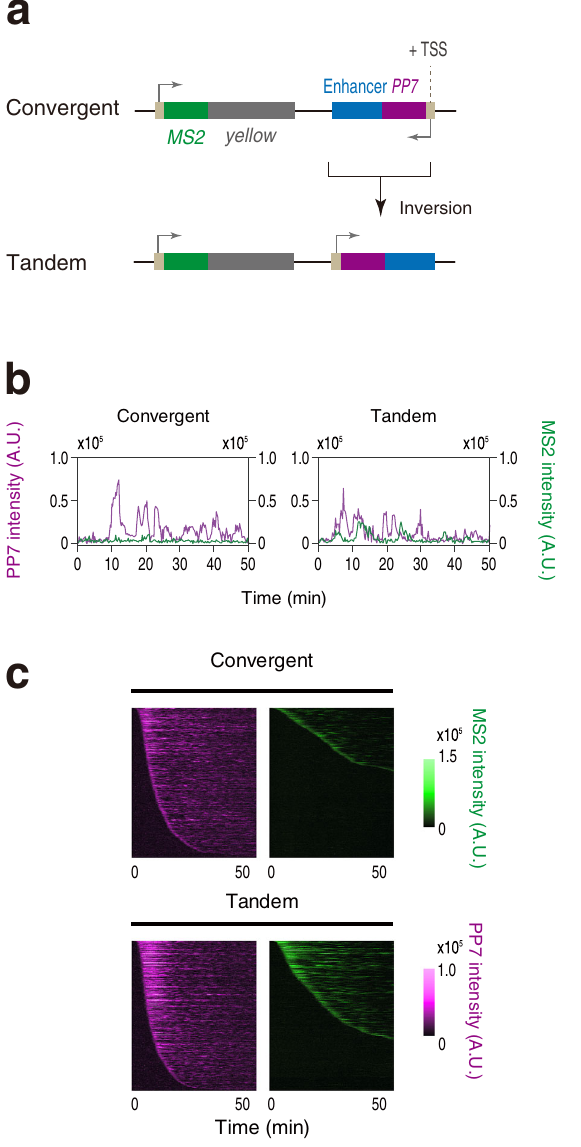
MS2burstfrequency.TheplotofConvergentisthesameastheplotof+TSSshown inFig.1f. f BoxplotshowingthedistributionofMS2burstsize.Theboxindicatesthe lower (25%) and upper (75%) quantile and the white line indicates the median. Whiskers extend to the most extreme, non-outlier data points. A total of 536 and 1055 MS2 bursts, respectively, were analyzed for the reporter locus driving non- coding enhancer transcription in a convergent or tandem orientation. The double hash mark on the y-axis indicates that >99% of the data points are presented. The plot of Convergent is the same as the plot of +TSS shown in Fig. 1g. g Boxplot showingthedistributionofthetotaloutputofMS2transcription.Theboxindicates the lower (25%) and upper (75%) quantile and the white line indicates the median. Whiskers extend to the most extreme, non-outlier data points. The plot of Con- vergent is the same as the plot of +TSS shown in Fig. 1h. A.U.; arbitrary unit. Per- centages shown at the bottom of the boxplots represent the relative values of the median. P values were calculated by a two-sided Wilcoxon rank-sum test. Source data are provided as a Source Data fi